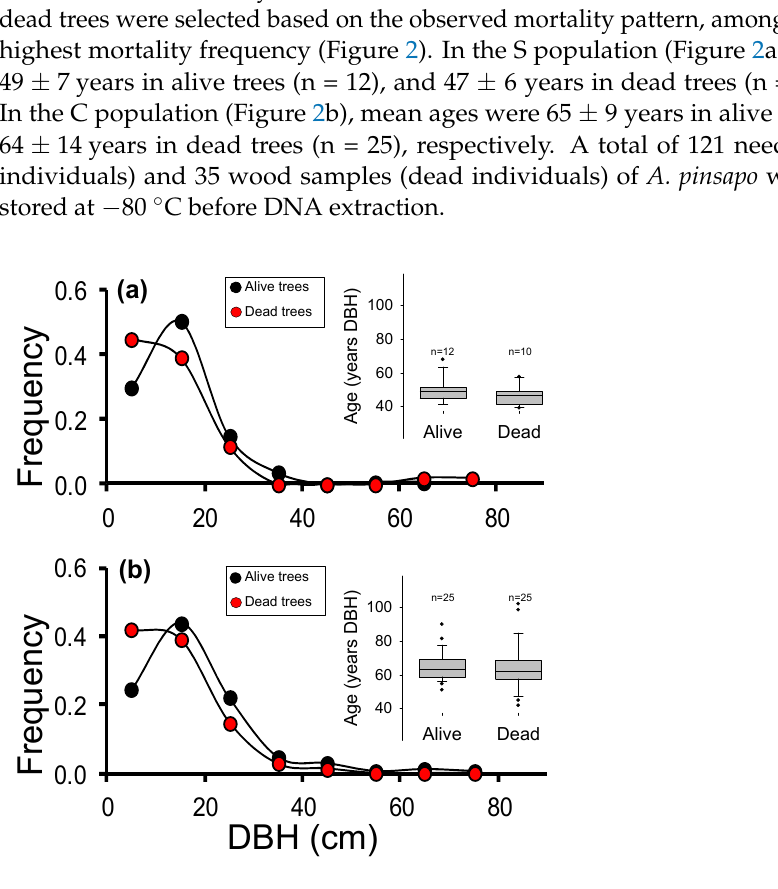
Figure 2. Frequency of size classes (diameter at breast height, DBH) observed in the live (black) and dead (red) trees in Saucillo population ( a ) and Caucon population ( b ). The insets show the age at DBH estimated on sampled live and dead trees, based on previous dendrochronological studies. In S population ( a ), mean ages were 49 ± 7 years in alive trees (n = 12), and 47 ± 6 years in dead trees (n = 10), respectively. In C population ( b ), mean ages were 65 ± 9 years in alive trees (n = 25), and 64 ± 14 years in dead trees (n = 25), respectively. In the box-plot figure, error bars represent the 5th/95th percentiles; boxes stand for the standard error; solid lines represent the median, and dots are